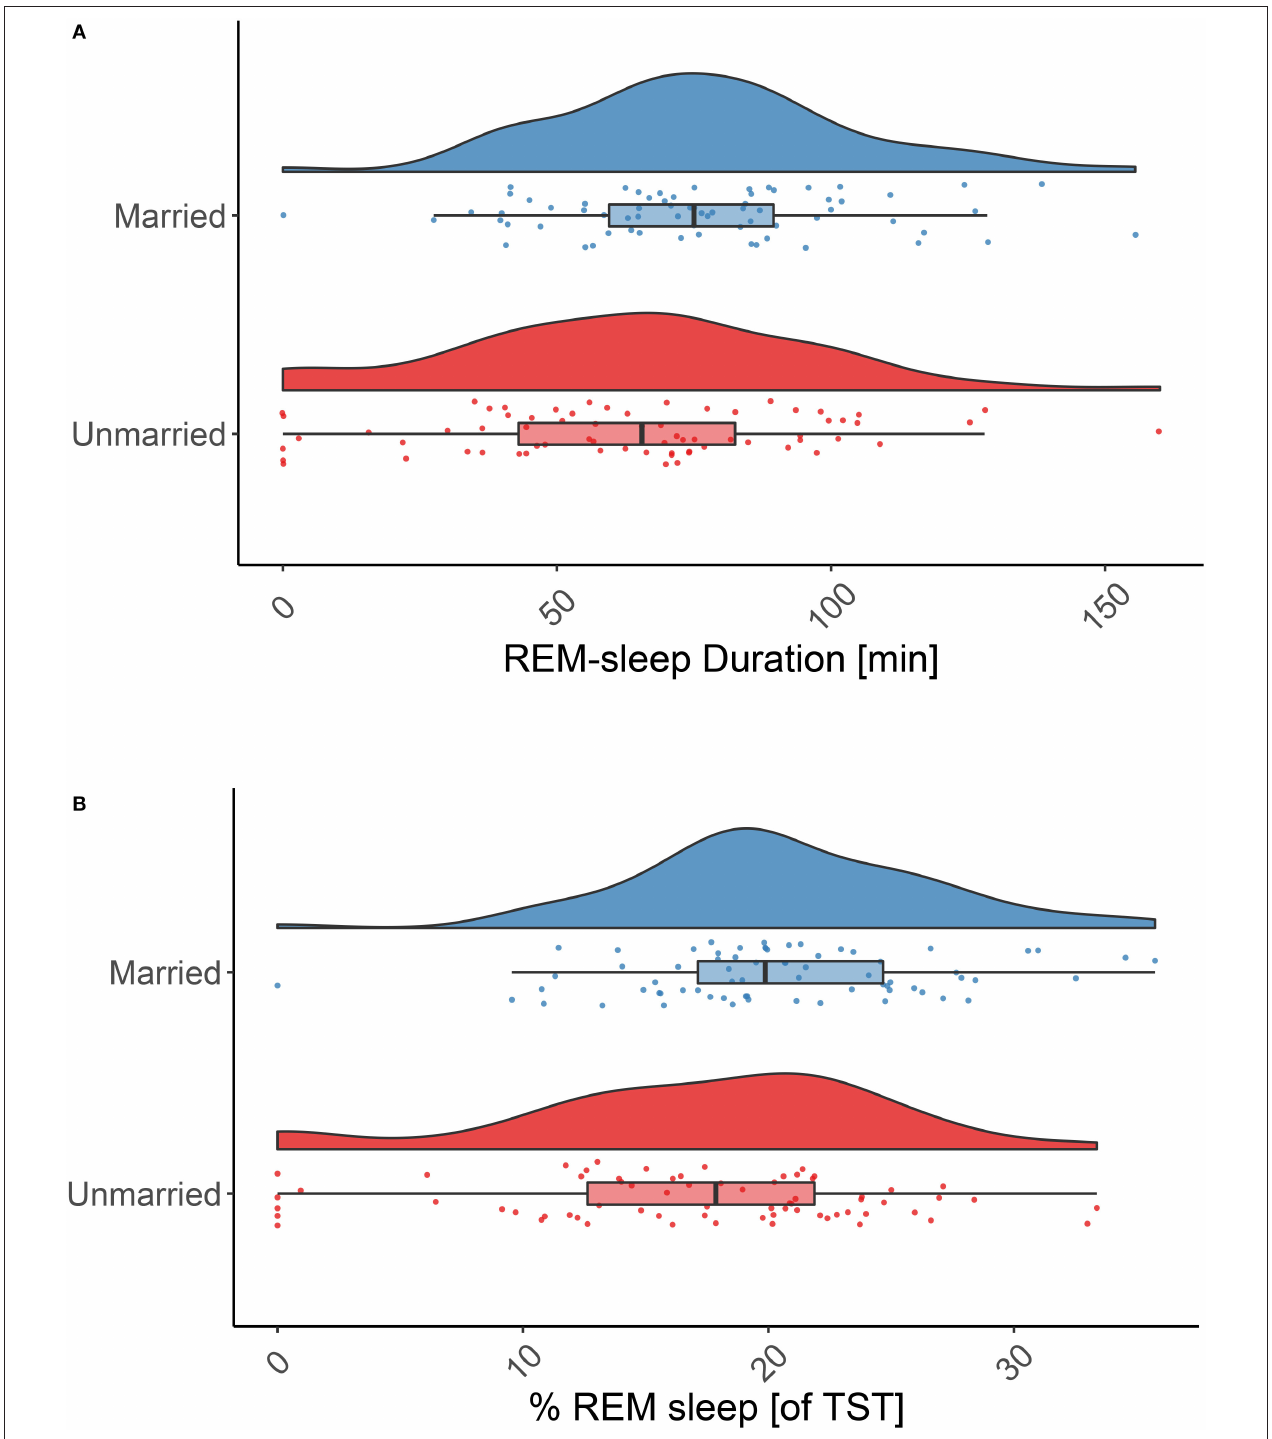
FIGURE 2 | REM sleep duration in married and never married individuals. Absolute (A) and relative (B) REM sleep duration is significantly higher in married individuals (blue raincloud plots) than in never married individuals (red raincloud plots): 76.5 ± 27.7min vs. 62.9 ± 33.1min, p = 0.003; and 20.5 ± 6.2% vs. 17.1 ± 7.7% p = 0.001. Note: the effect remains significant if individuals with no or little REM sleep ( ≤ 3min) are excluded ( p = 0.023 absolute REM sleep amount and p = 0.015 relative amount of REM sleep). Tests: paired, one-sided t -tests.